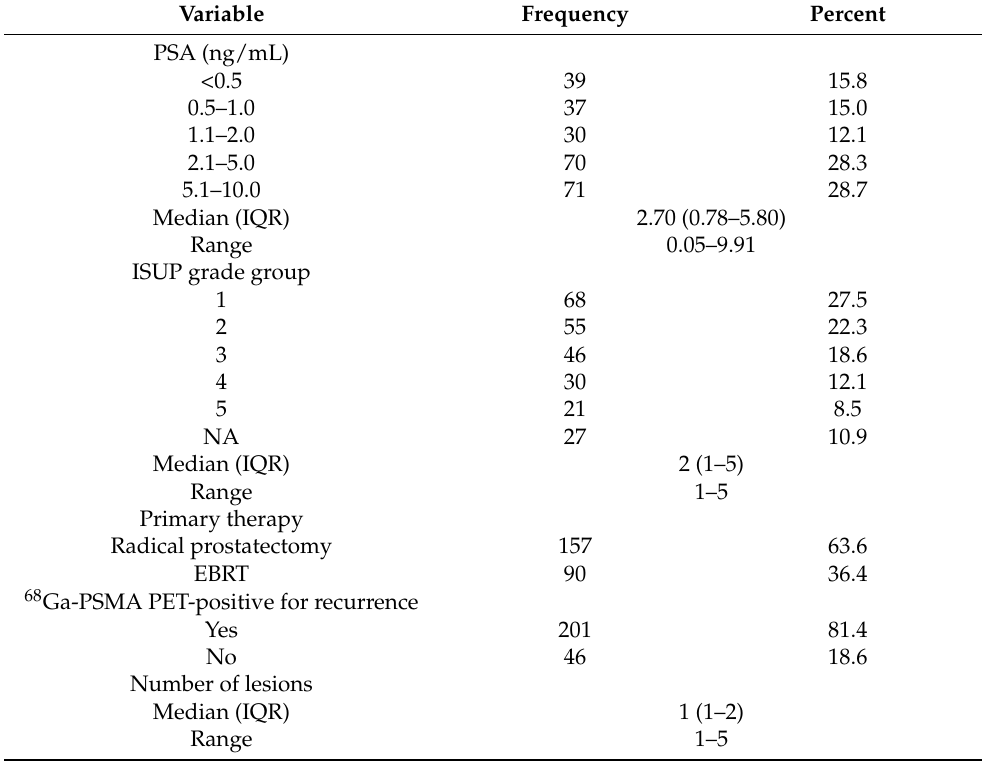
Table 1. Demography, baseline disease-related characteristics, and 68 Ga-PSMA-11 PET/CT positivity